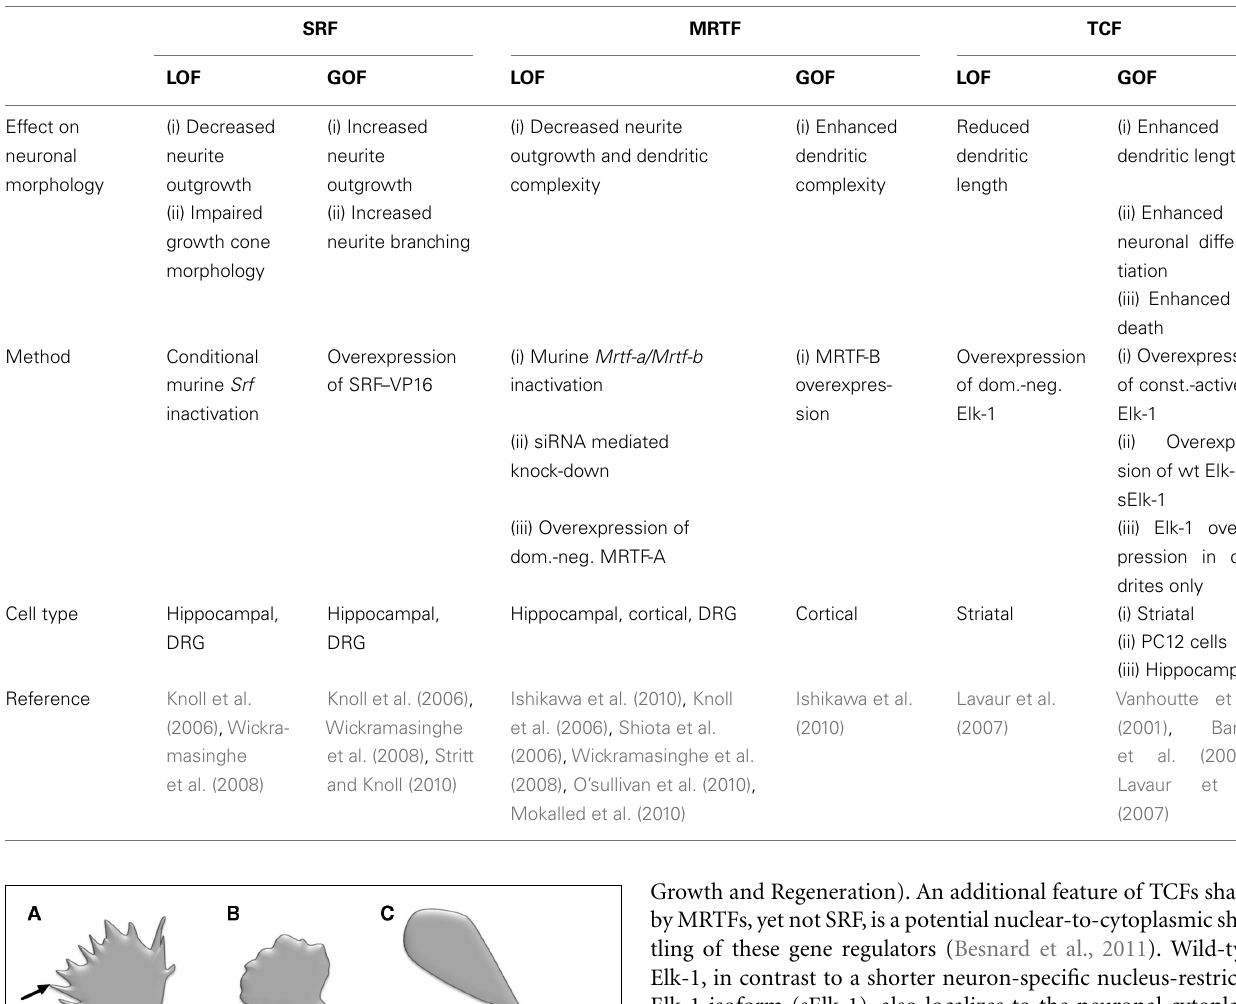
Table 1 | Summary of effects imposed on neuronal morphology upon SRF, MRTF andTCF loss of-function (LOF) and gain-of-function (GOF).